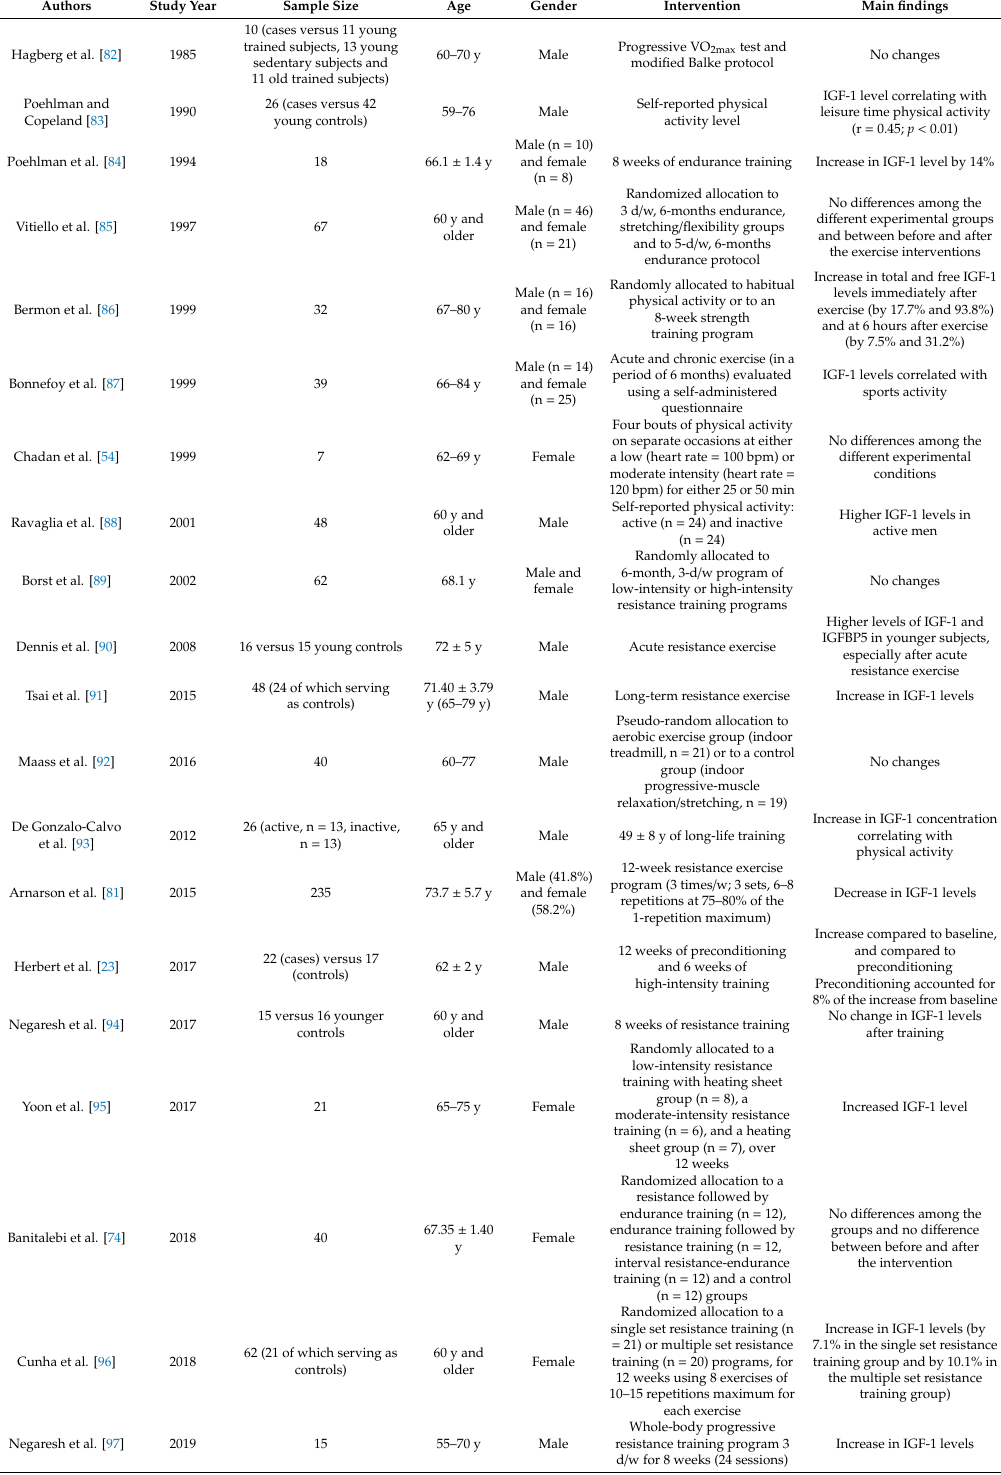
Table 3. Studies investigating the e ff ects of physical activity and exercise on IGF-1 in elderly subjects.